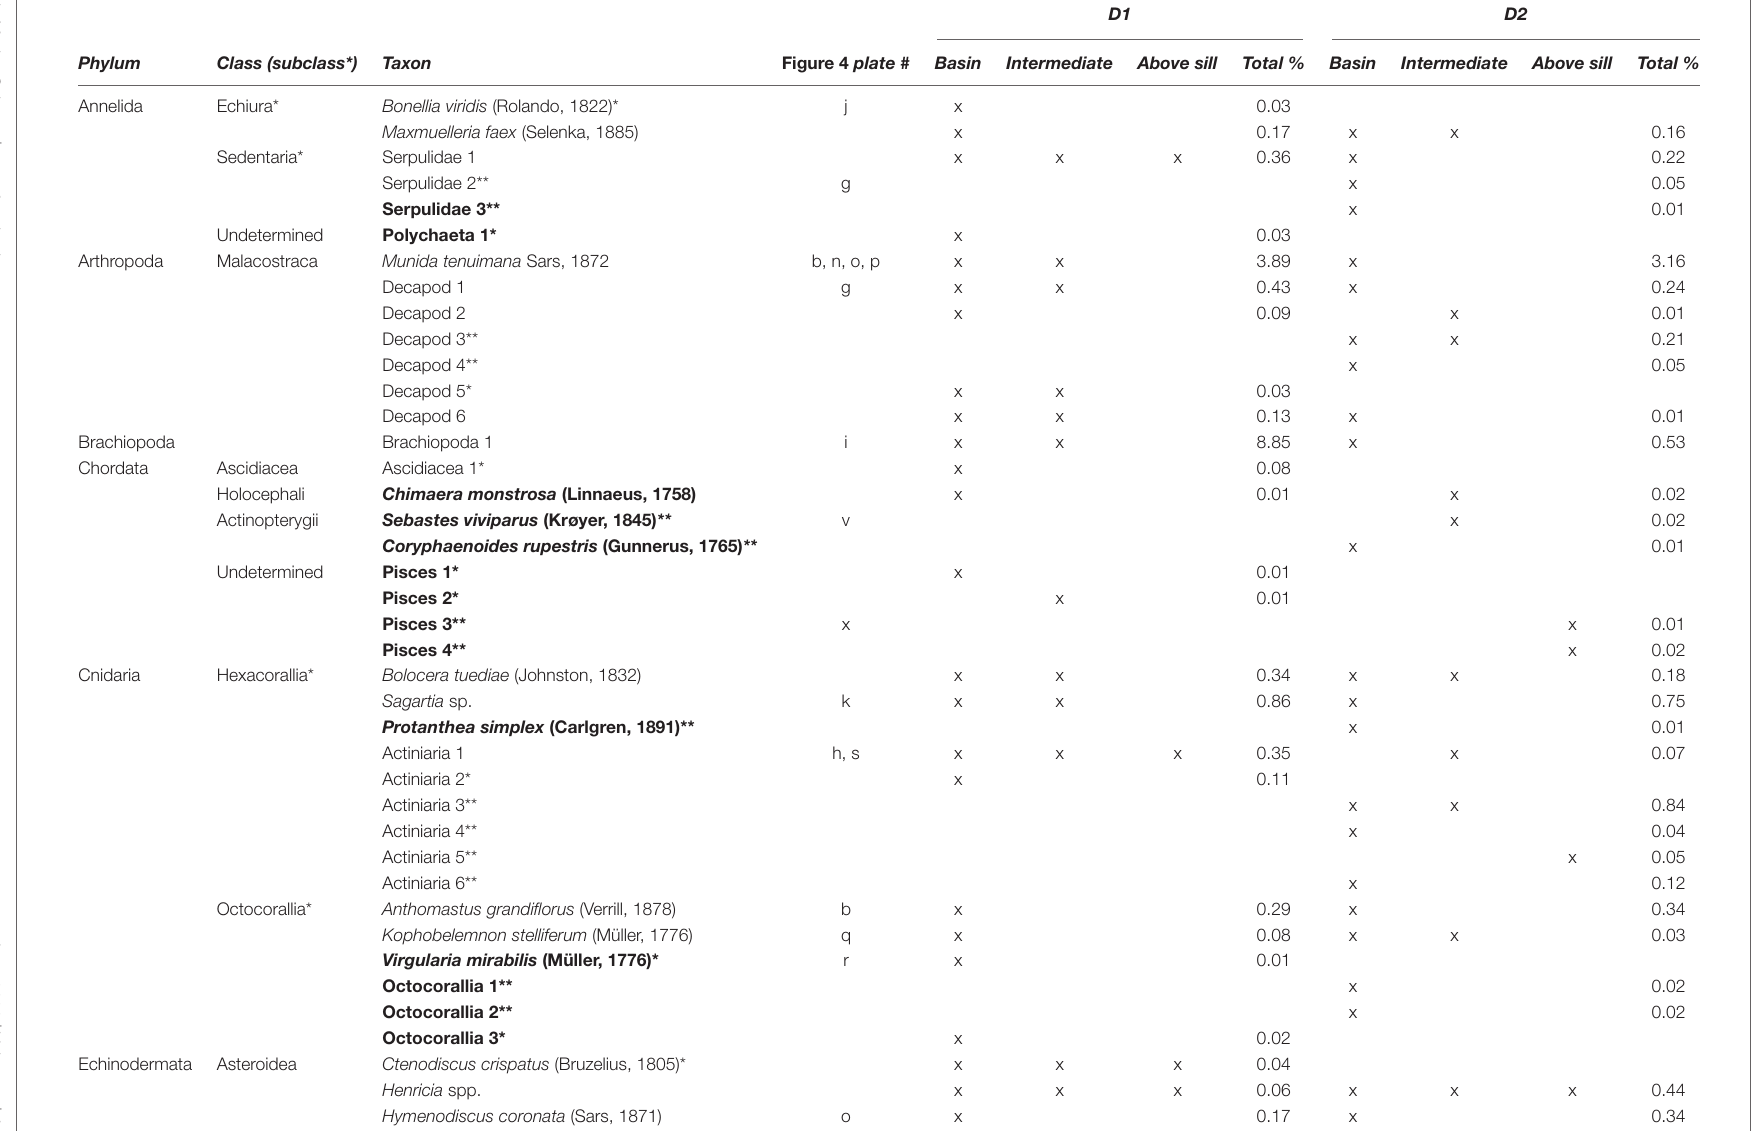
TABLE 2 | The presence (x) of all megafauna within each depth zone for Dive 1 (left) and Dive 2 (right) in Sognefjord, Norway.